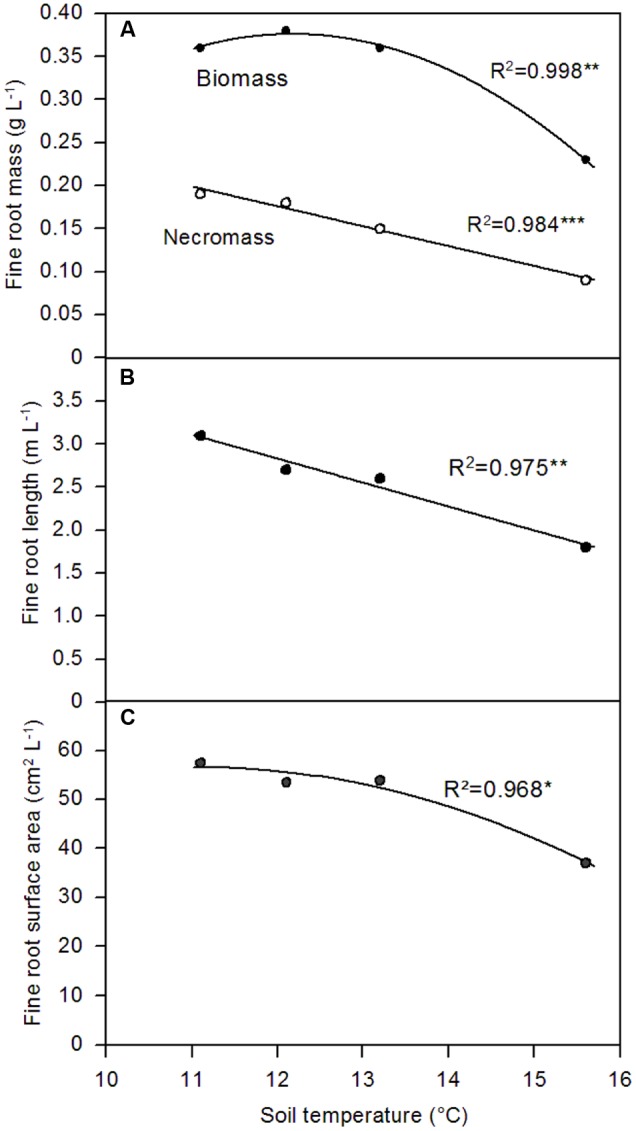
Dependence of fine root biomass and necromass density (A), cumulative fine root length per soil volume (B), and cumulative fine root surface area per volume (C) of P. cembra on median soil temperature measured at 10 cm depth. The measuring points in the plots were assigned to the four temperature categories #1 to #4 which represent the quartiles of soil temperature values measured in the six plots during the early afternoon measurement; ∗p < 0.05, ∗∗p < 0.01, ∗∗∗p < 0.001.